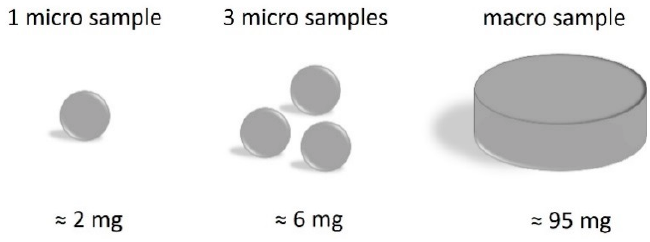
Figure 3. The shape and approximate weight of the samples.